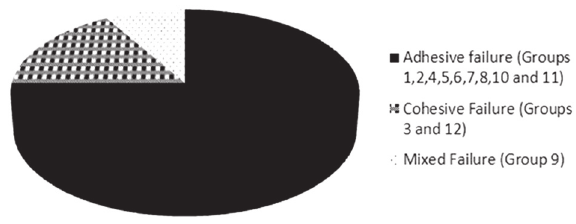
Figure 2: Type of bonding failure for all groups